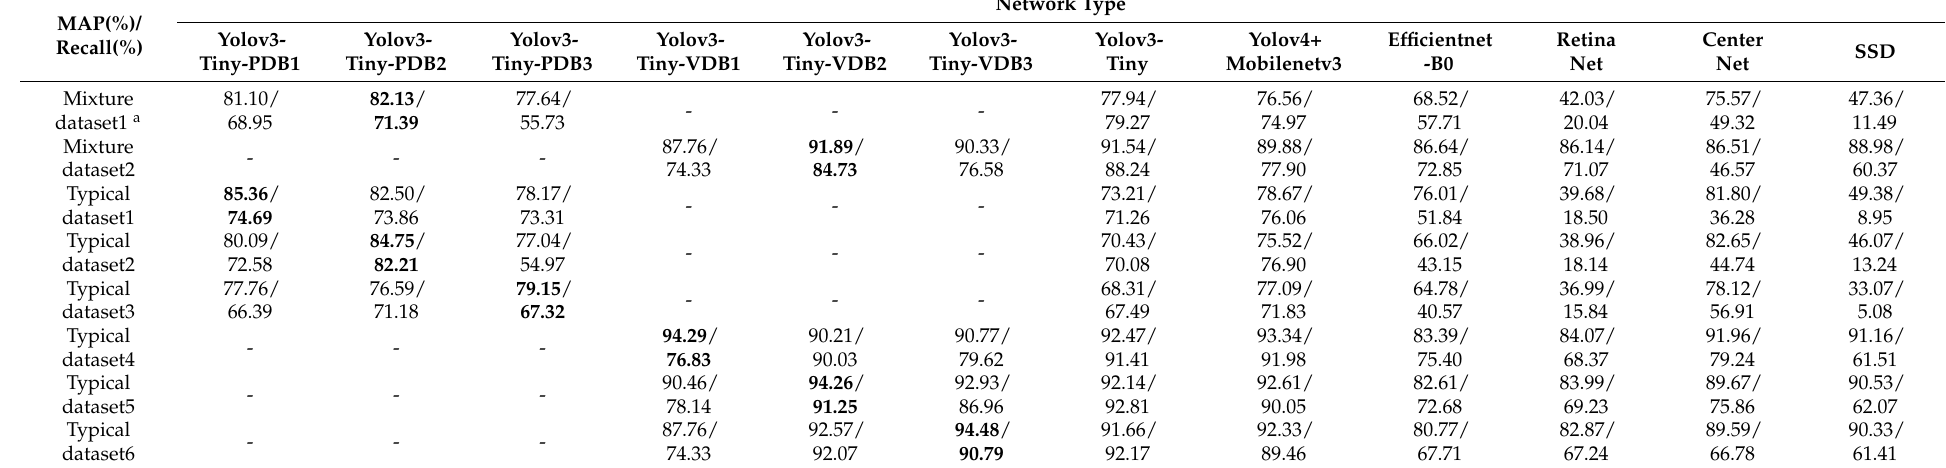
Table 5. Detection accuracy comparisons using different deep learning networks and test datasets.